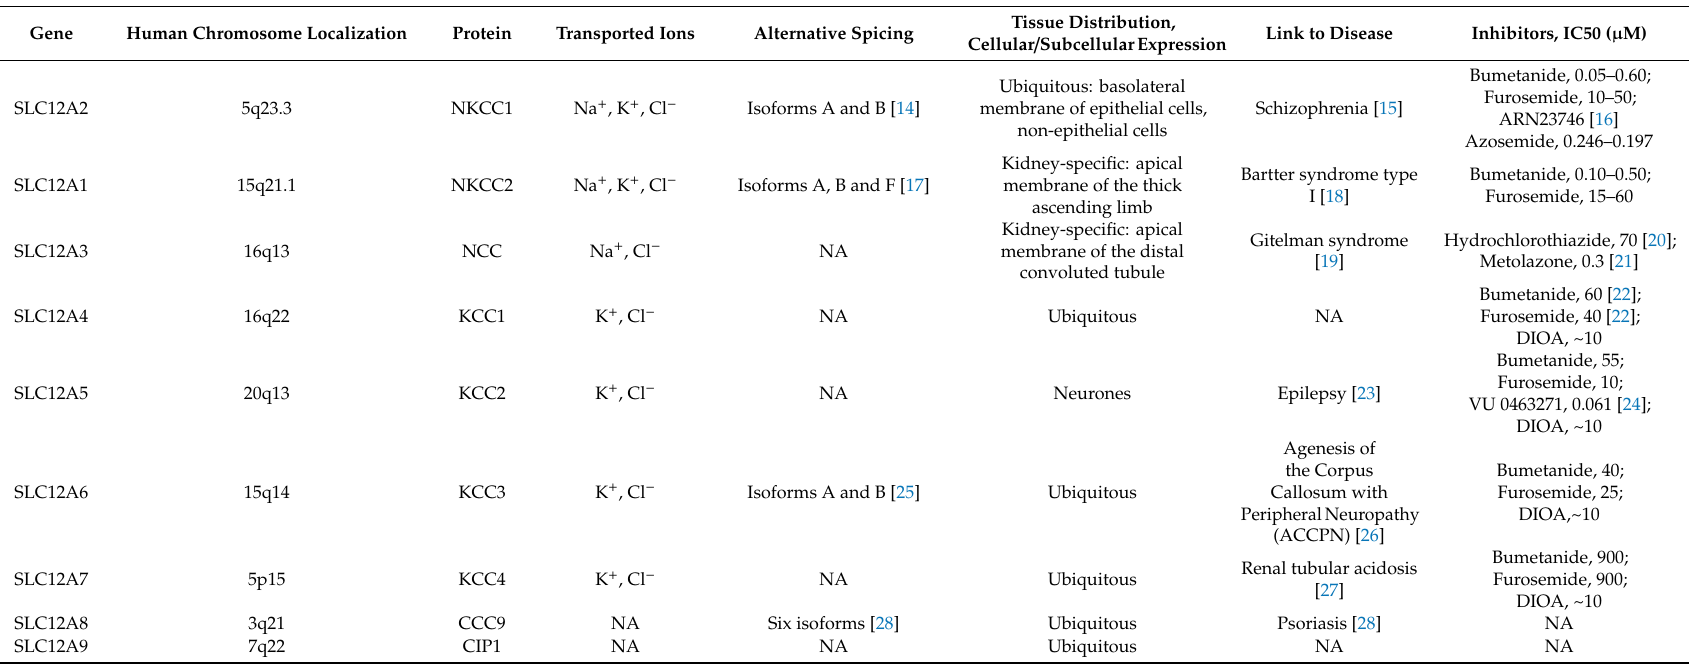
Table 1. Major characteristics of Cl − -coupled cation cotransporters